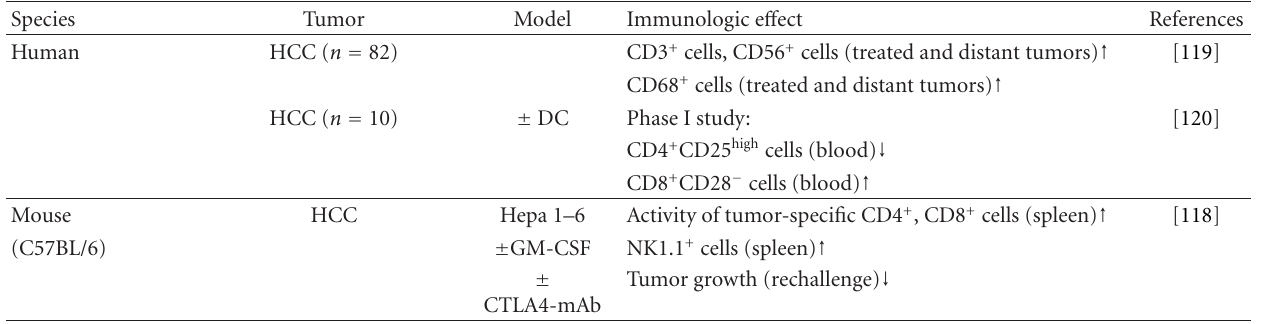
Table 4: Studies reporting immune modulation in cancer patients and animal models treated with MWA.